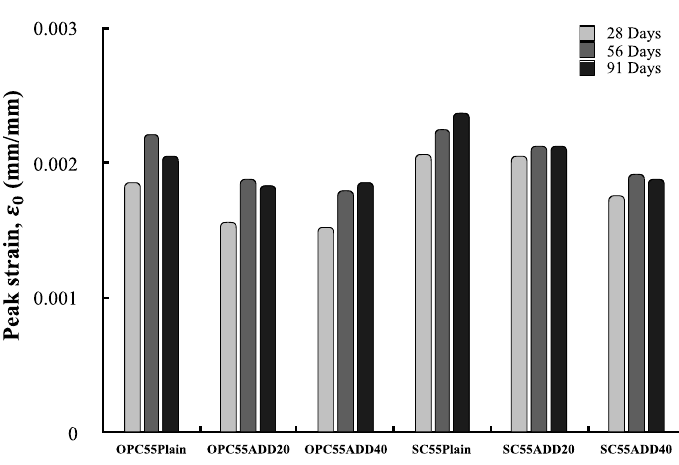
Figure 19. Peak strain of LRM concrete with cement type.